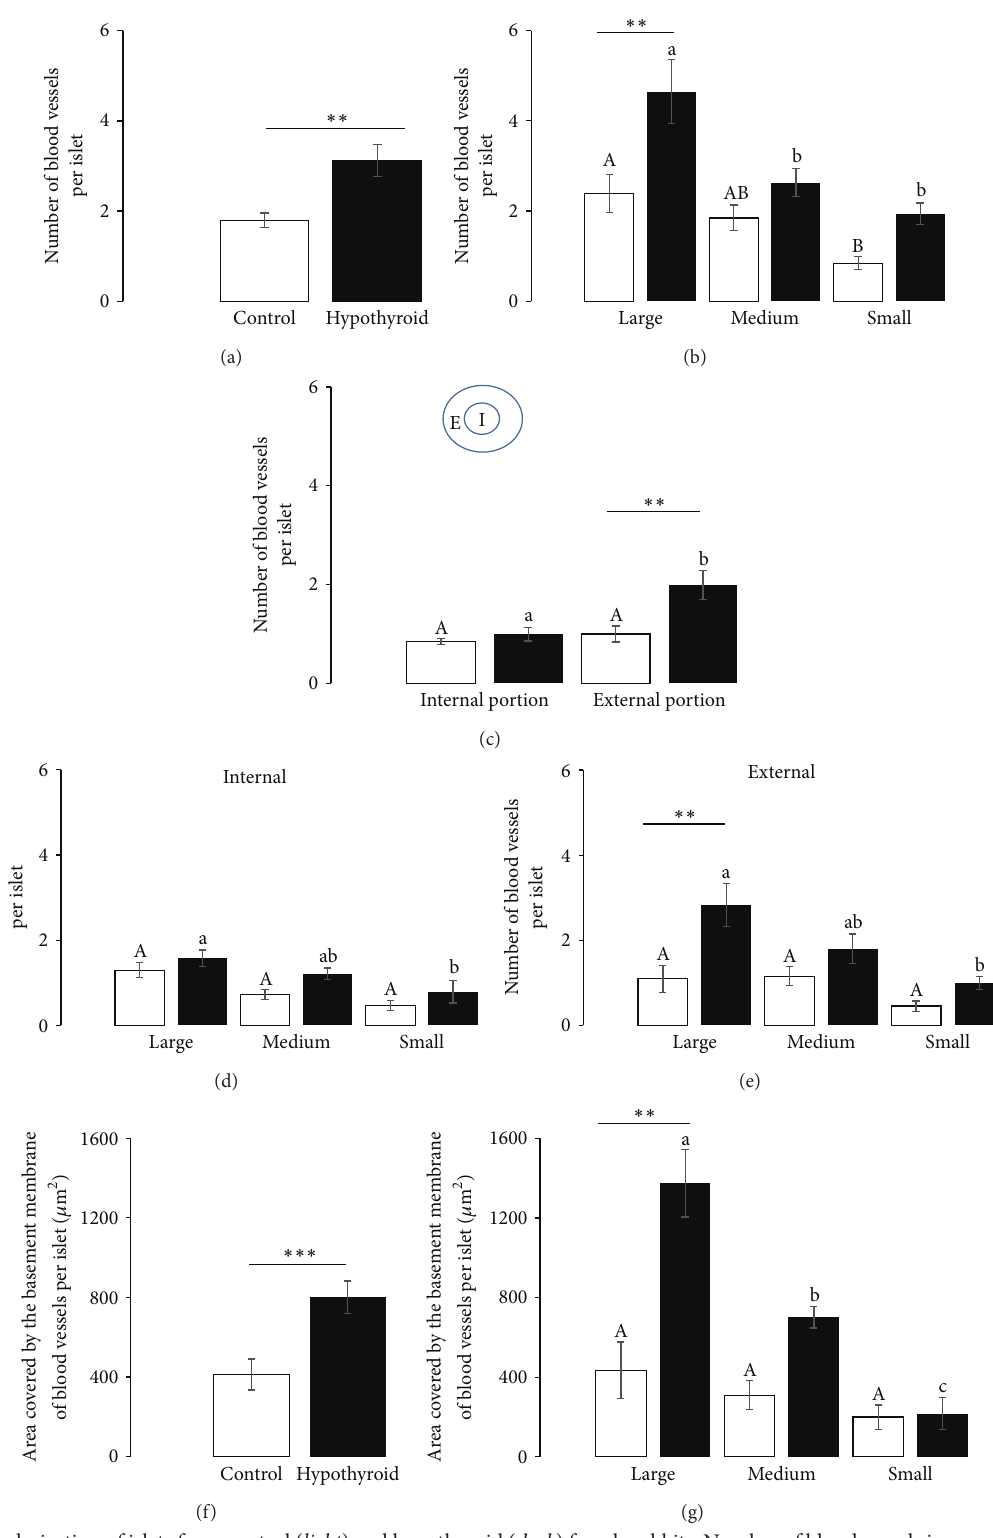
Figure 2: Vascularization of islets from control ( light ) and hypothyroid ( dark ) female rabbits. Number of blood vessels in overall islets (a), in islets categorized by size (b), in portions of the islets (c), in the internal portion of islets categorized by size (d), and in the external portion of islets categorized by size (e). Area covered by the basement membrane of blood vessels for overall islets (f) and categorized by size (g). Different capital letters indicate significant differences between sizes of islets in control females. A similar order is given by lowercase letters for hypothyroid females. Asterisks indicate significant differences between treatments ∗∗ 𝑃 < 0.01 and ∗∗∗ 𝑃 < 0.001 . E: external portion of the islet; I: internal portion of the